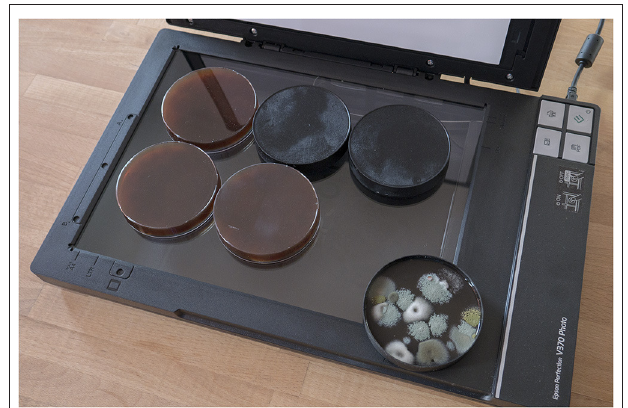
FIGURE 3 | The Epson Perfection V370 Photo flatbed scanner used in our experiment, with several Petri dishes upside down on the scanning area. One dish is turned upright to show considerable microbial growth. Different growth medium colors are the result of experimentation with ingredients that included instant coffee powder or activated carbon powder.